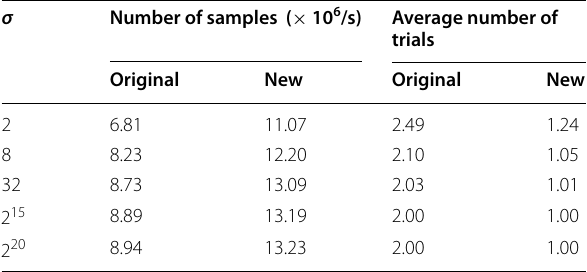
Table 9 Comparison between the original COSAC sampler and the new COSAC sampler at 3.6 GHz